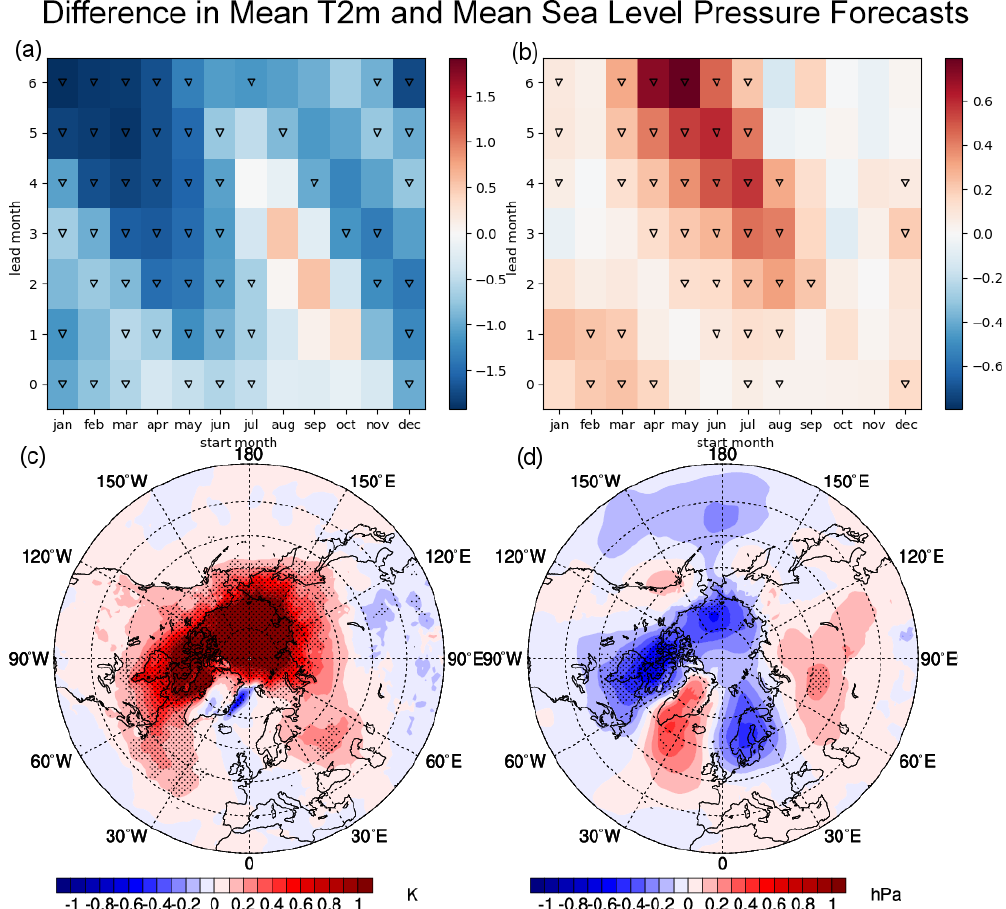
Figure 11. Mean forecast differences between FC-SIT and FC-REF 2011–2016: (a) bias in mean 2m temperature (in K) north of 50 ◦ N with respect to ERA5, as a function of start dates and lead months, in FC-REF; panel (b) is similar to panel (a) but with a difference in mean 2m temperature (in K) between FC-SIT and FC-REF. Triangles denote significant changes according to the sign test as recommended by DelSole and Tippett (2016) at the 5% level. Mean forecast difference (FC-SIT – FC-REF) for SON aggregated from May, June, July and August start dates of (c) 2m temperature and (d) mean sea level pressure. Dots indicate areas of significant changes on the 95% level according to the Kolmogorov–Smirnov